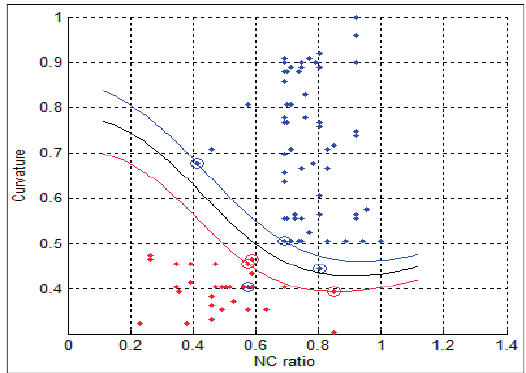
Figure 14. SVM separation for benign and malignant classes by using NC ratio and curvature features (perfectly separable). Red points corresponding to benign cells and blue points corresponding to malignant cells. The black line represent the